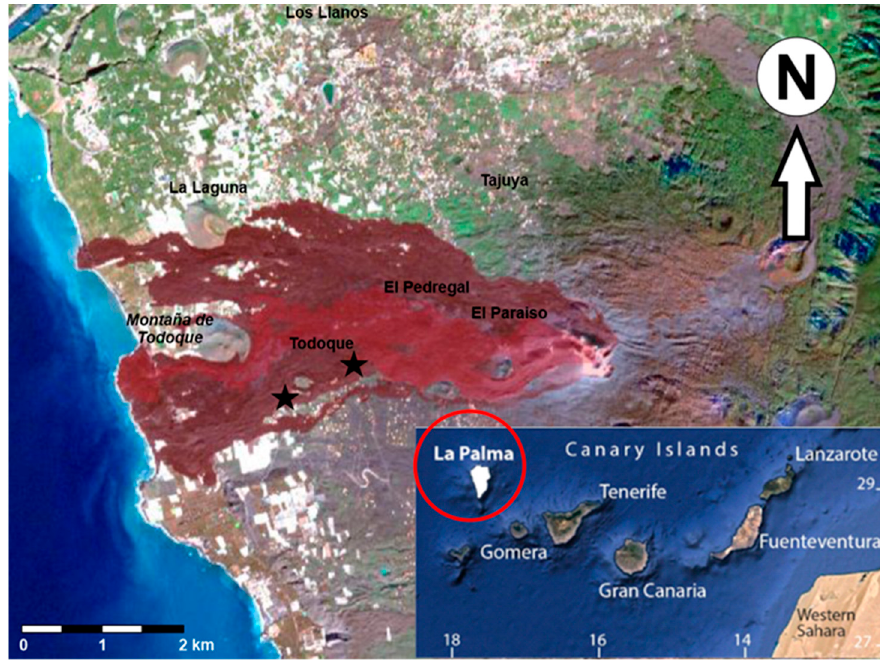
Figure 1. Location of Cumbre Vieja within the Canary Islands, including lava-flow sample locations (stars). Lava and lapilli sample location can be found in Table 1.